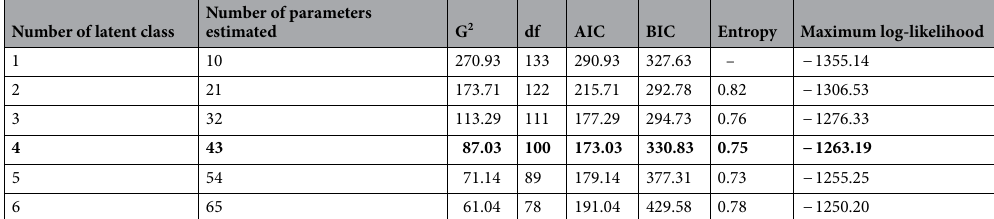
Table 2. Comparison of LCA Models with different latent classes based on model selection Statistics. LCA latent class analysis, AIC Akaike information criterion, BIC Bayesian information criterion. Significant values are in